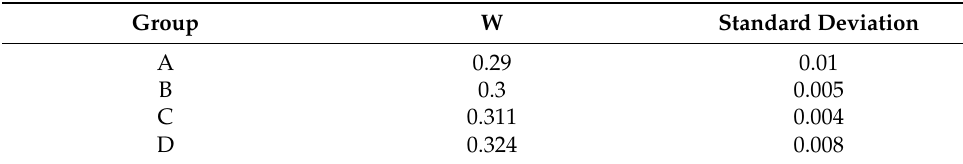
Table 1. Cryopanels arrangement versus W.